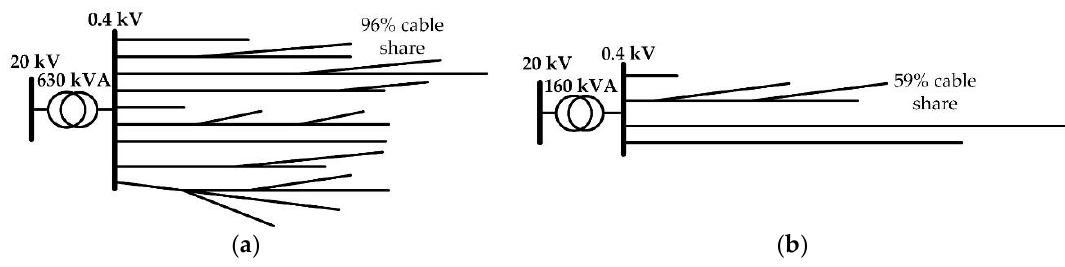
Figure 18. Schematic presentation of different real low-voltage grids (LVGs): ( a ) urban and ( b ) rural.